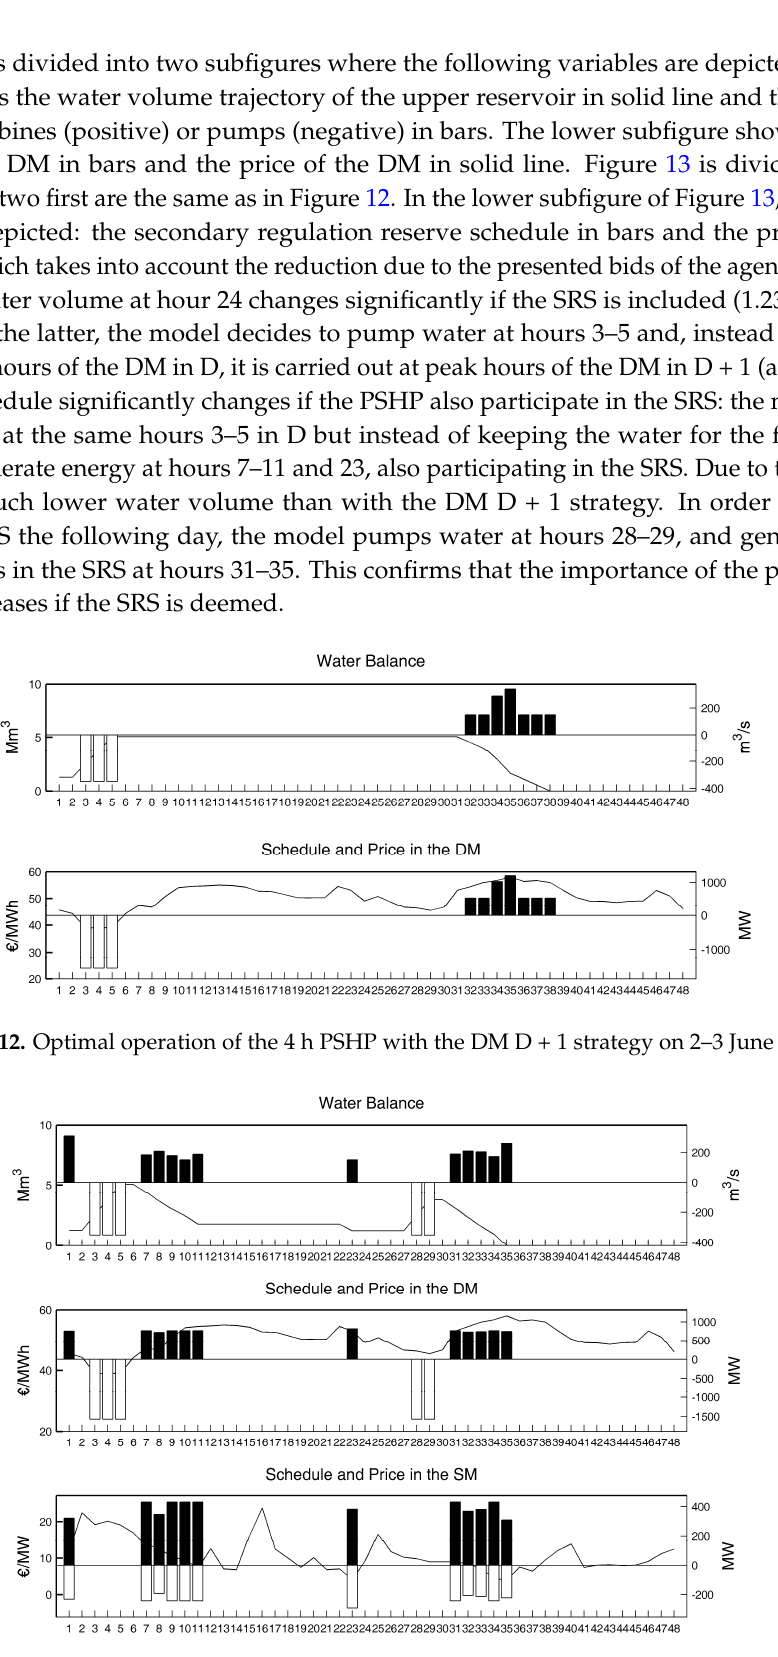
Figure 13. Optimal operation of the 4 h PSHP with the SRS D + 1 strategy on the 2–3 June 2014.